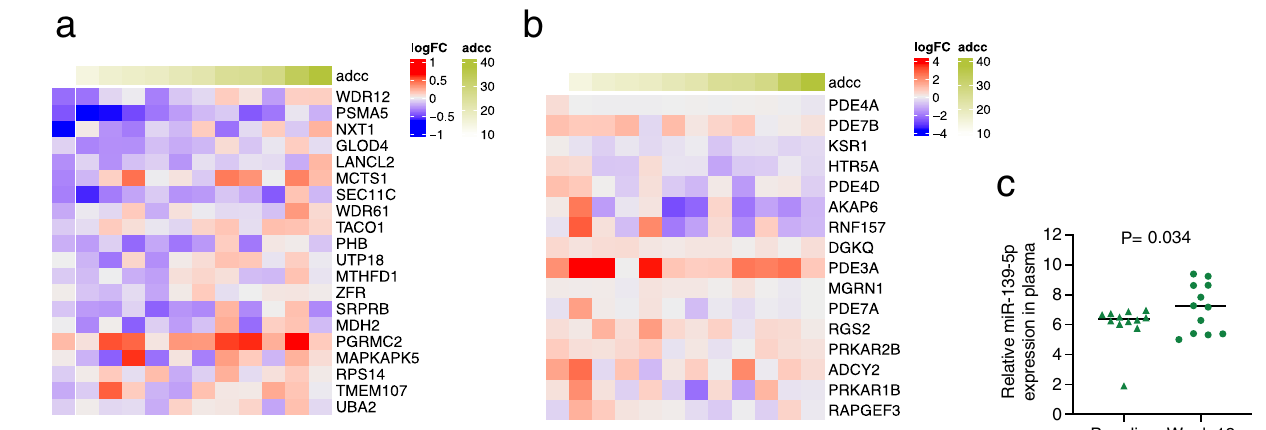
Fig. 4 | CREB1 pathway activation and ADCC. a Heatmap representations of the log 2 fold-change (logFC) expression (week 13/baseline) in CD14 + cells ( n =12 ani- mals) of 20 genes involved in the cellular response to cAMP identi fi ed by Tomalka et al. 40 and their correlation with V2-speci fi c ADCC. b Heatmap representations of thelog 2 fold-changeexpression(week13/baseline)inCD14 + cells( n =12animals)of 16genesinvolvedinGeneOntologyBiologicalProcess(GOBP)relatedtothecAMP-